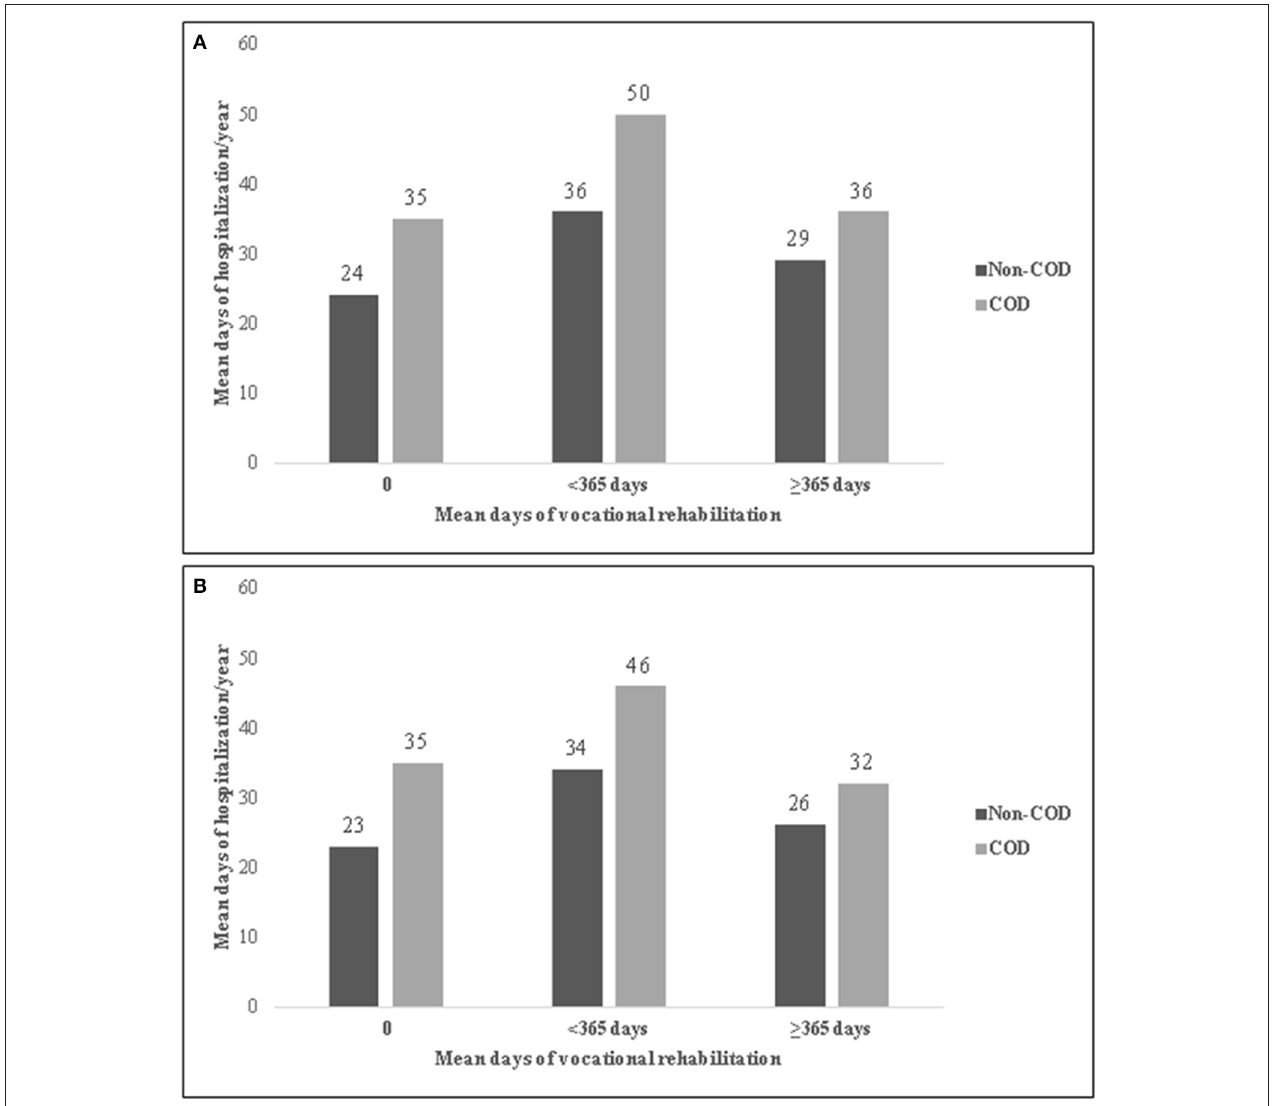
FIGURE 2 | Mean psychiatric hospitalization days per year by duration of vocational rehabilitation in Period 1 (2001–2009) (A) and Period 2 (2010–2016) (B) , among hospitalized persons with co-occurring disorders (COD) of chronic psychotic disorder and SUD, Israel, 2010–2016. (A) Period 1 . (B) Period 2